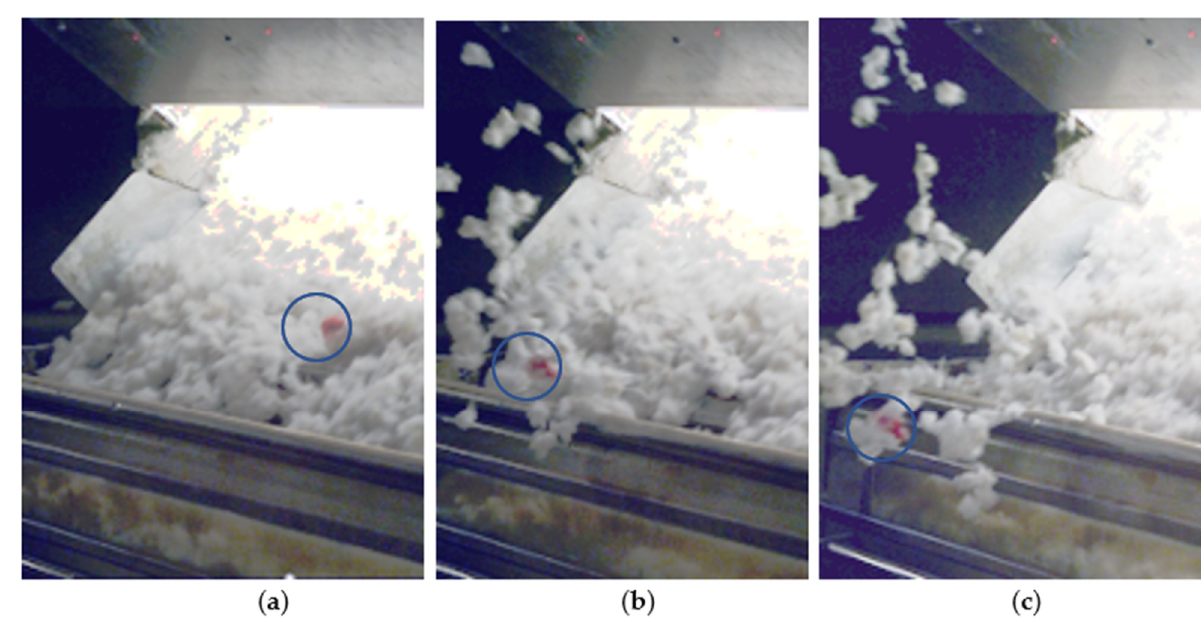
Figure 7. Plastic inspection–detection and ejection system (“PIDES”). Plastic removal system in operation, taken with high-speed video. ( a ) Target (inside circle) just before ejection, after detection. ( b ) Target during ejection process. ( c ) Target after ejection is complete.